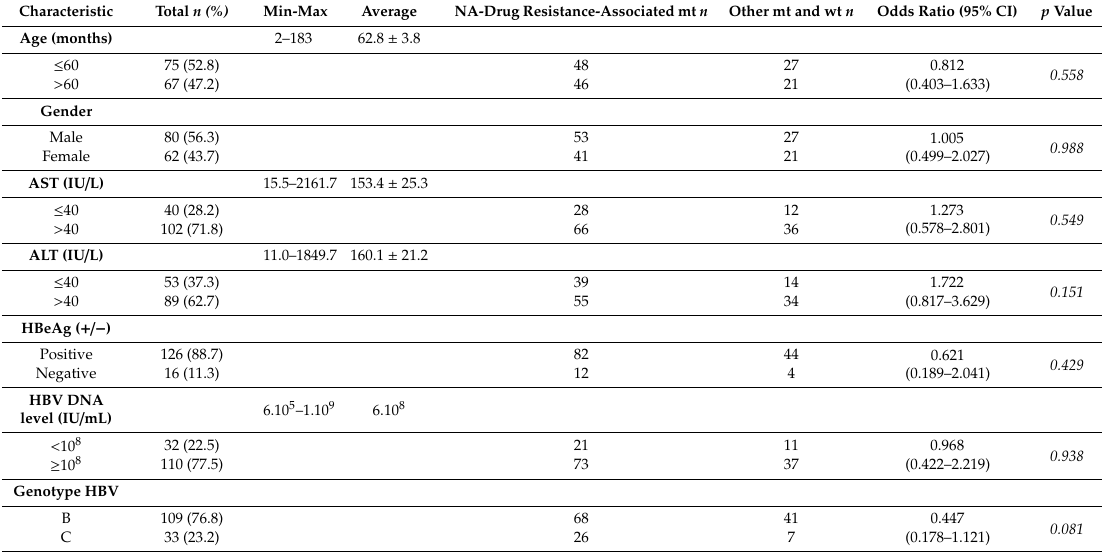
Table 1. Clinical features of treatment-naïve children with chronic hepatitis